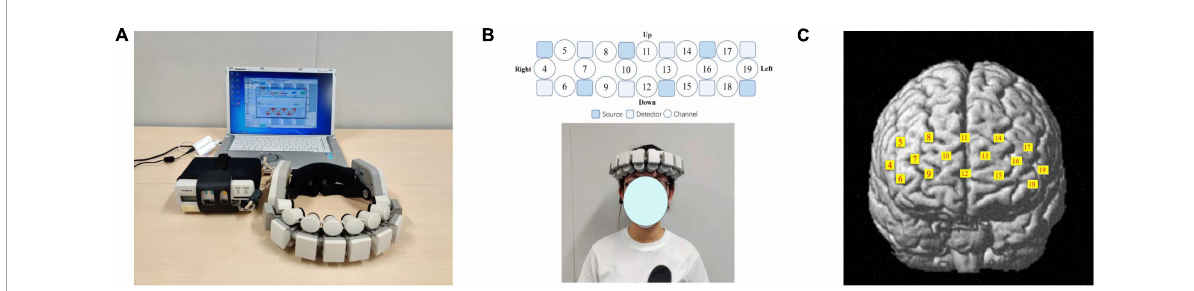
FIGURE1 The setting of the NIRS device. (A) The WOT-100 device, including the handset, mobile control box, net-box, and measurement controller. (B) An example of a participant wearing the WOT-100 device on the frontal head, and the source, detector, and channel setting of the WOT-100. (C) The spatial registration of each channel on the frontal cortex.